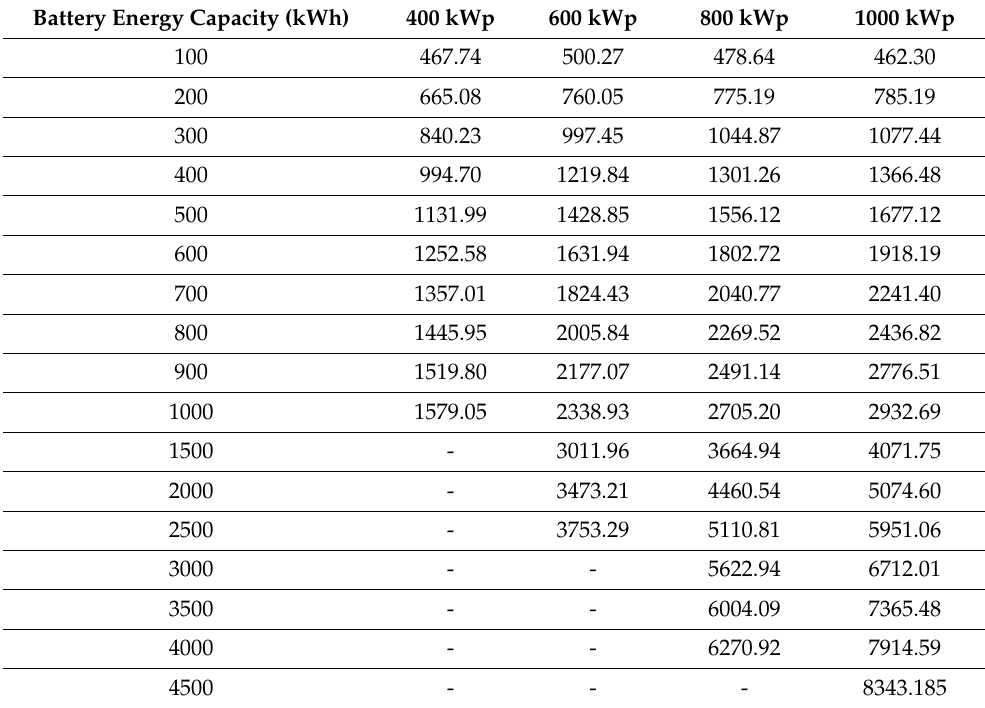
Table 6. Estimated annual amount of hydrogen production in kg produced from surplus energy generated by the PV installation.